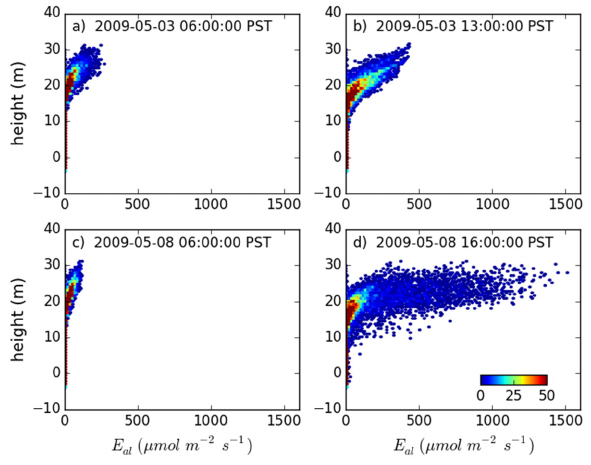
Figure 4. Simulation results of absorbed PAR for 6:00 PST ( a ) and 13:00 PST ( b ) on the cloudy day of 3 May 2009; and for 6:00 PST ( c ) and 16:00 PST ( d ) on a sunny day (8 May 2009) plotted as a 2D heat map. The gap fraction, GF K , of photosynthetic scene elements, p l , was set to 15%. The x -axis is incident PAR ( µ mol photons m ´ 2 ¨ s ´ 1 ) and the y -axis is height above the ground level at the plot centre. Colours represent observation frequency for an arbitrary, constant bin